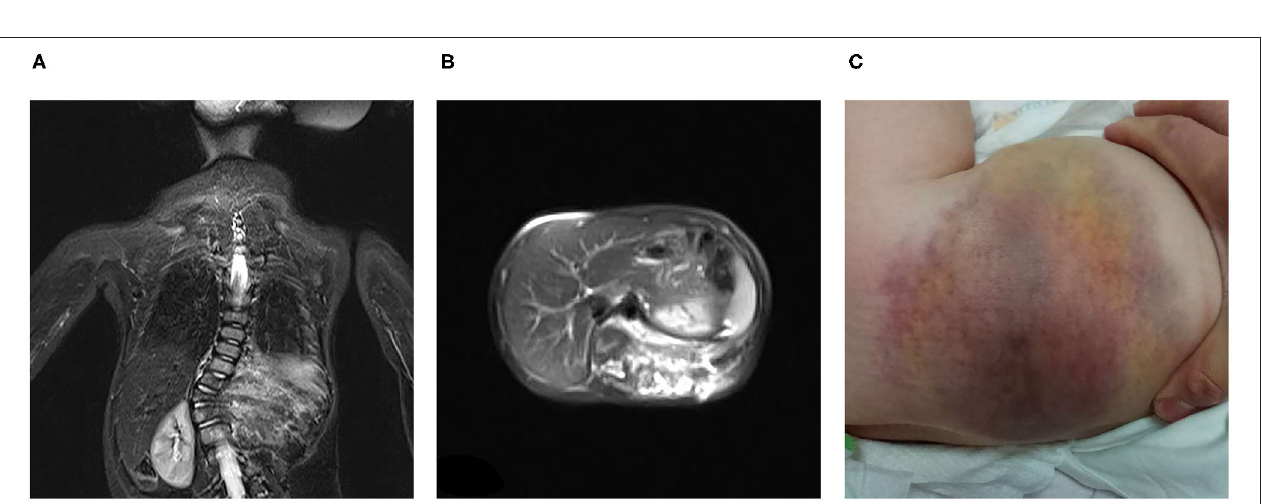
FIGURE 4 | KHE in Patient 6: The MRI showed that large mixed signal mass involved the left lumbar and back, and T7-L4 vertebrae and paraspinal tissue from coronal (A) and sagittal position (B) , and we can see that the skin on the left waist and back was involved (C) .